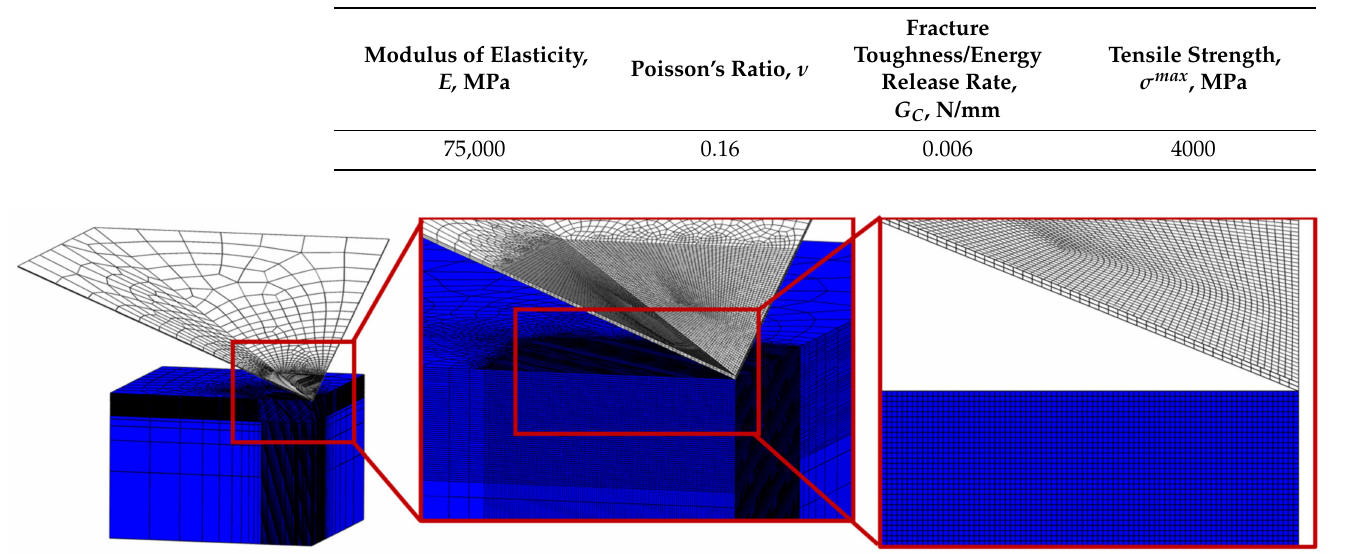
Table 4. Elastic material parameters for brittle phase-field formulation used in this study.